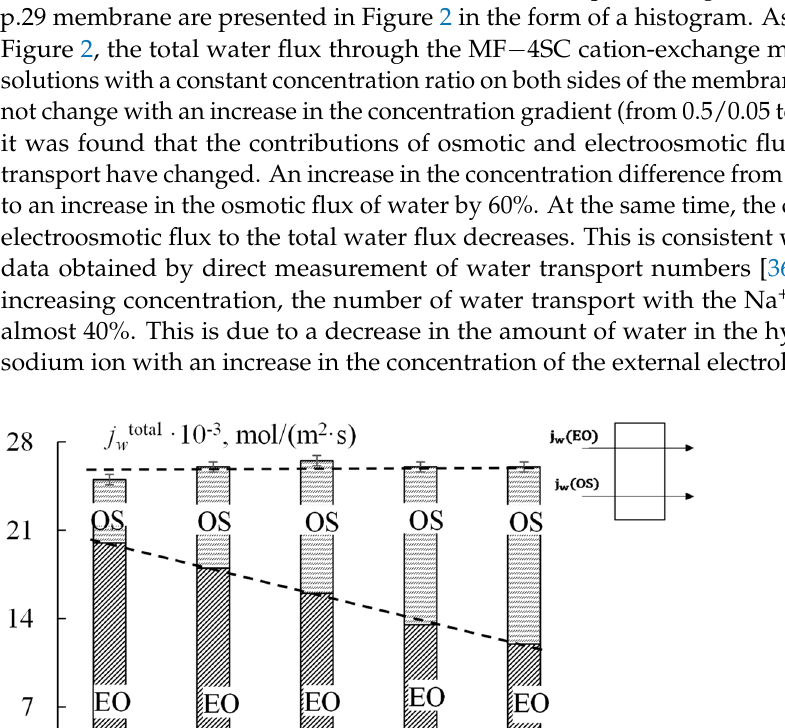
Table 1. Parameters of the MF − 4SC extrusion p.29 membrane in NaCl solution.